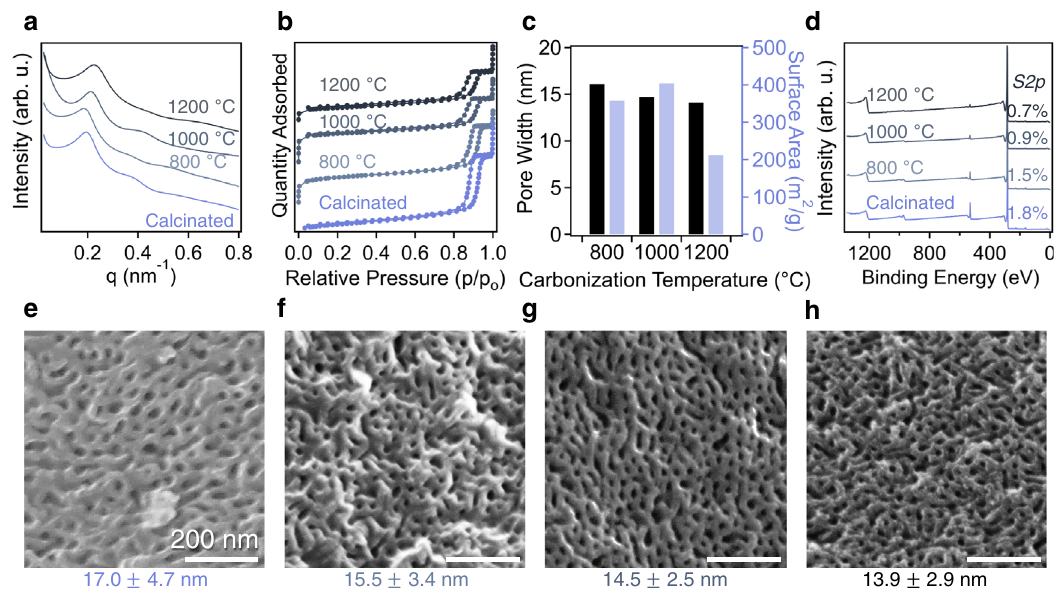
Fig. 3 | Characterization of SEBS-derived ordered mesoporous materials. a SAXS patterns for ordered mesoporous polymer and SEBS118-derived OMC car- bonized at 800°C, 1000°C, 1200°C. b Nitrogen adsorption isotherms which exhibit type IV isotherms, indicating the presence of mesopores. For clarity, the isotherms have been shifted in the positive Y-direction. c Pore width calculated through NLDFT models for carbon slit pores at 77K and the Brunauer-Emmett-